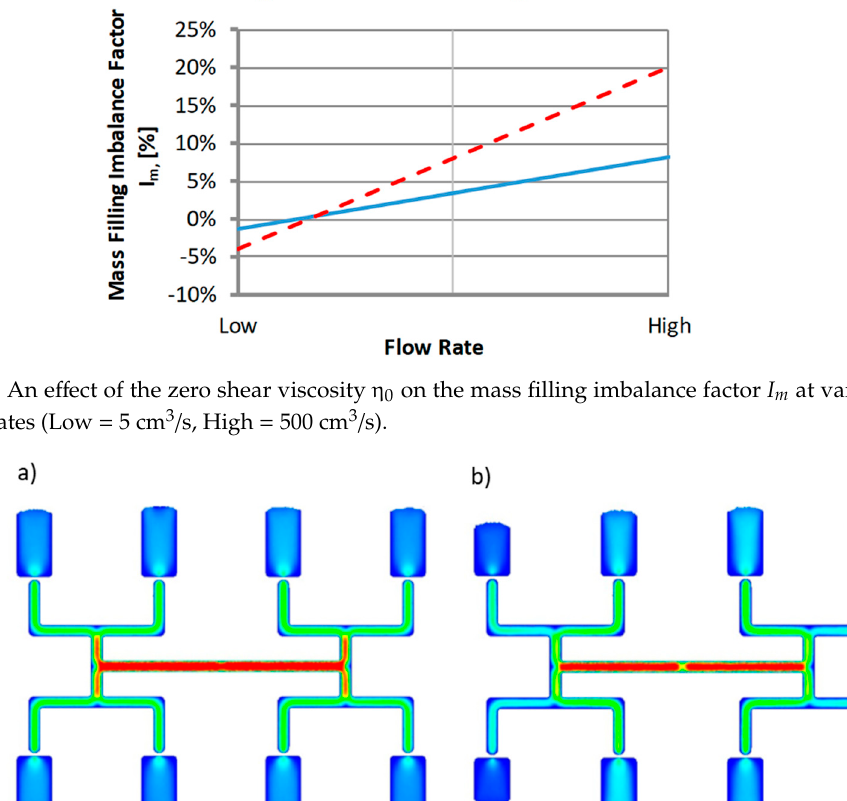
Figure 13. An effect of the relaxation time λ on the mass filling imbalance factor I m at various injection rates (Low = 5 cm 3 /s, High = 500 cm 3 /s).